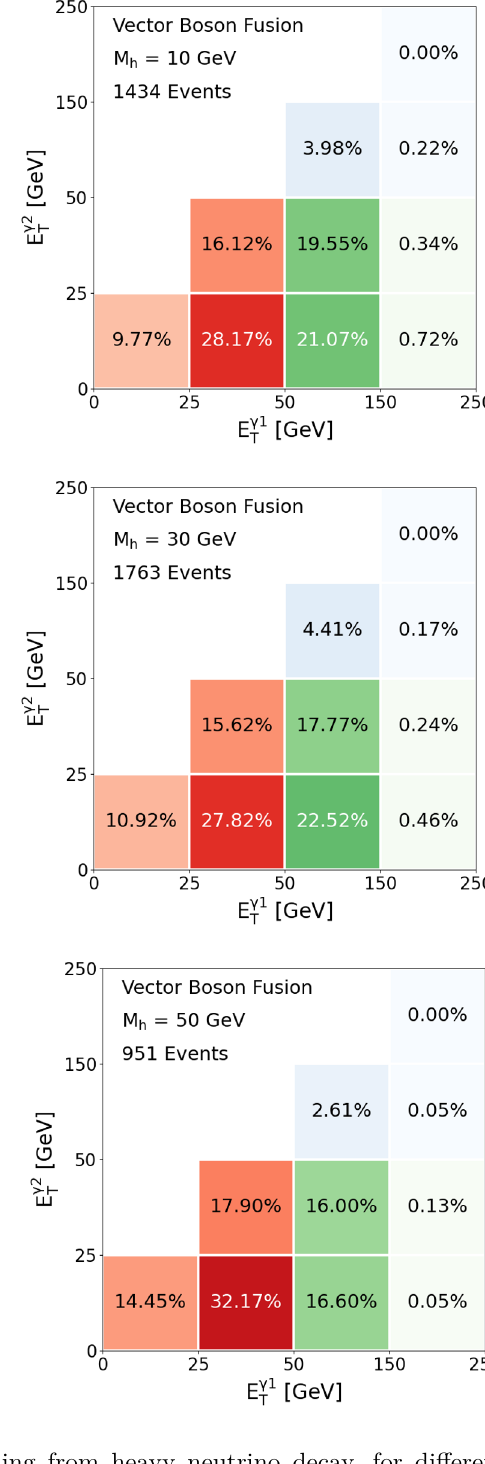
Figure 5 . Percentage of two-photon events coming from heavy neutrino decay, for different energy bins. Higgs production via GF (VBF) is shown on the left (right) column. Results for M h = 10 , 30 , 50 GeV are shown on the top, center, bottom rows, respectively. Number of events refers to those where both photons are contained within the detector. See text for